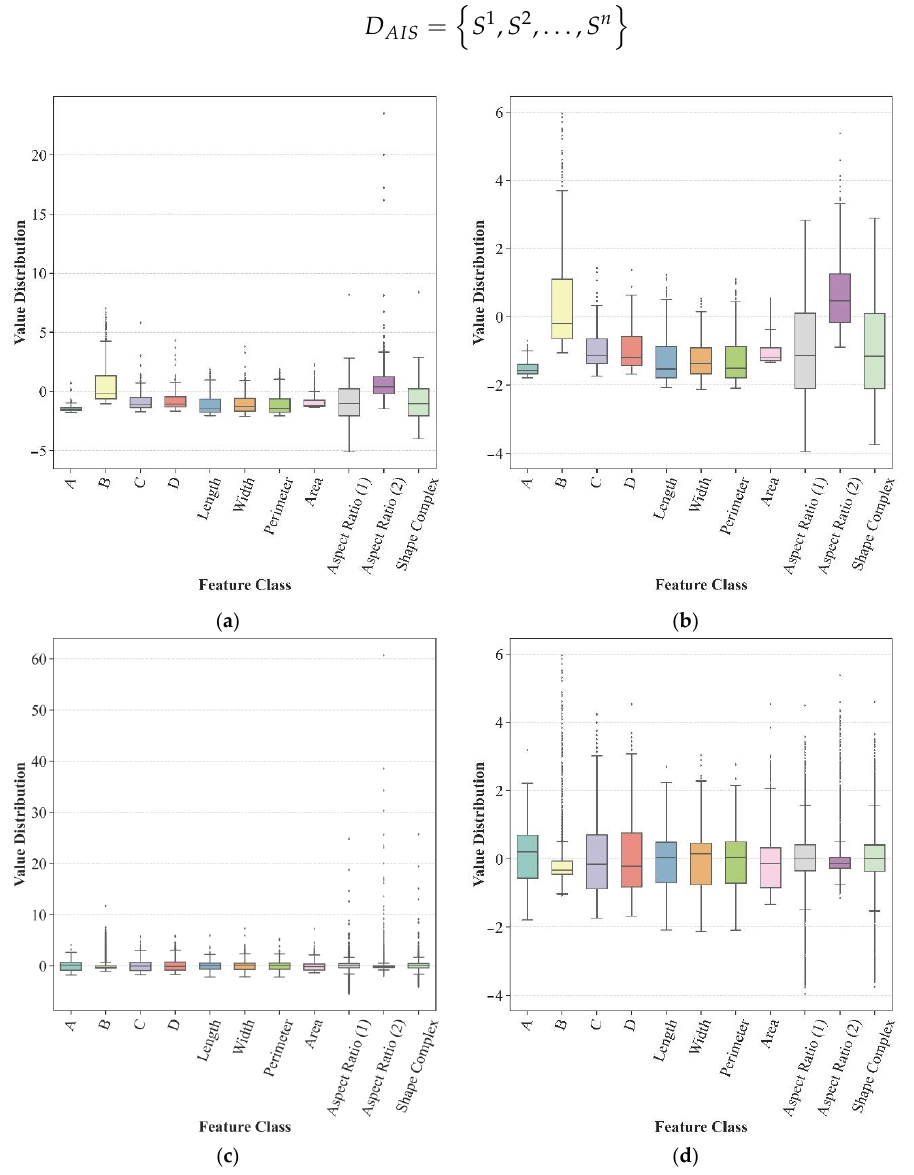
Figure 4. Visualization results of AIS data samples before and after removing outliers. ( a ) Distribution of original passenger ship SGFs; ( b ) distribution of passenger ship SGFs after removing outliers; ( c ) distribution of original AIS data ship SGFs; and ( d ) distribution of AIS data ship SGFs after removing